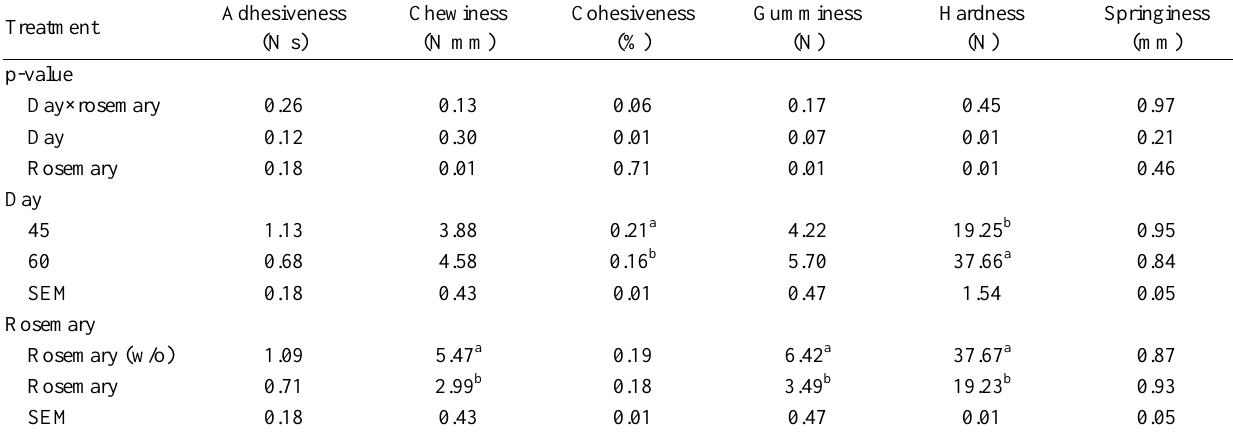
Table 5. Texture properties of salchichon modified sausage after 45 or 60 d ripening and/or added rosemary powder